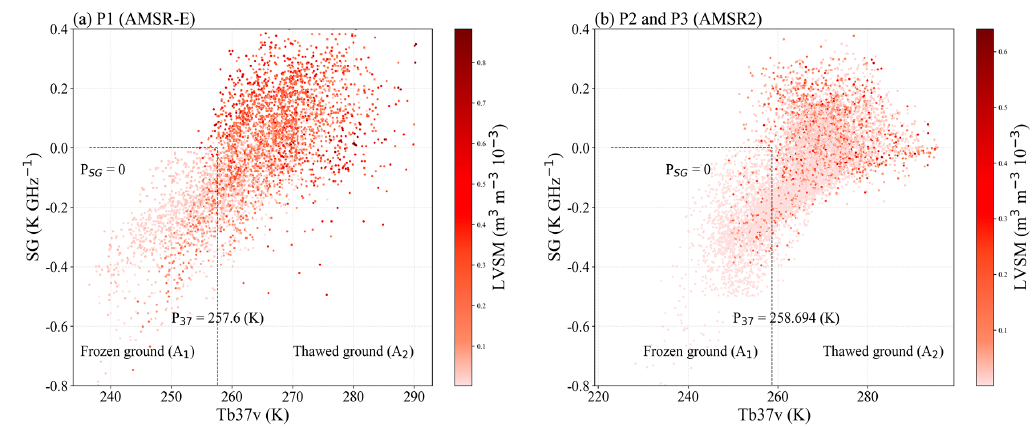
Figure 7. The scatter plot of LVSM along with corresponding cluster data of Tb37v and spectral gradient (SG) over the periods of P1 ( a ) and P2, P3 ( b ). gradient (SG) over the periods of P1 ( a ) and P2, P3 ( b